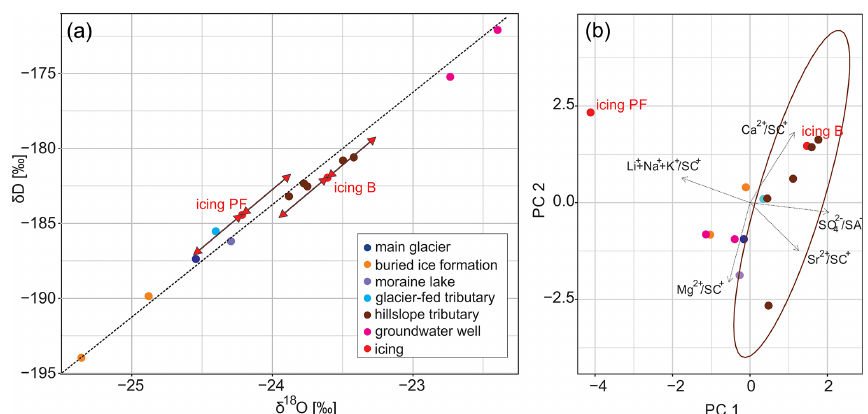
Figure 5. Isotopic and hydrochemical method results for Watershed B. Panel (a) shows results from stable water isotope analysis. The straight dashed line represents the local meteoric water line. Red arrows define the range within which samples from parent sources are considered to plot close to the icing sample. Panel (b) shows results of the hydrochemical analysis, and the ellipse illustrates the 95% confidence interval.